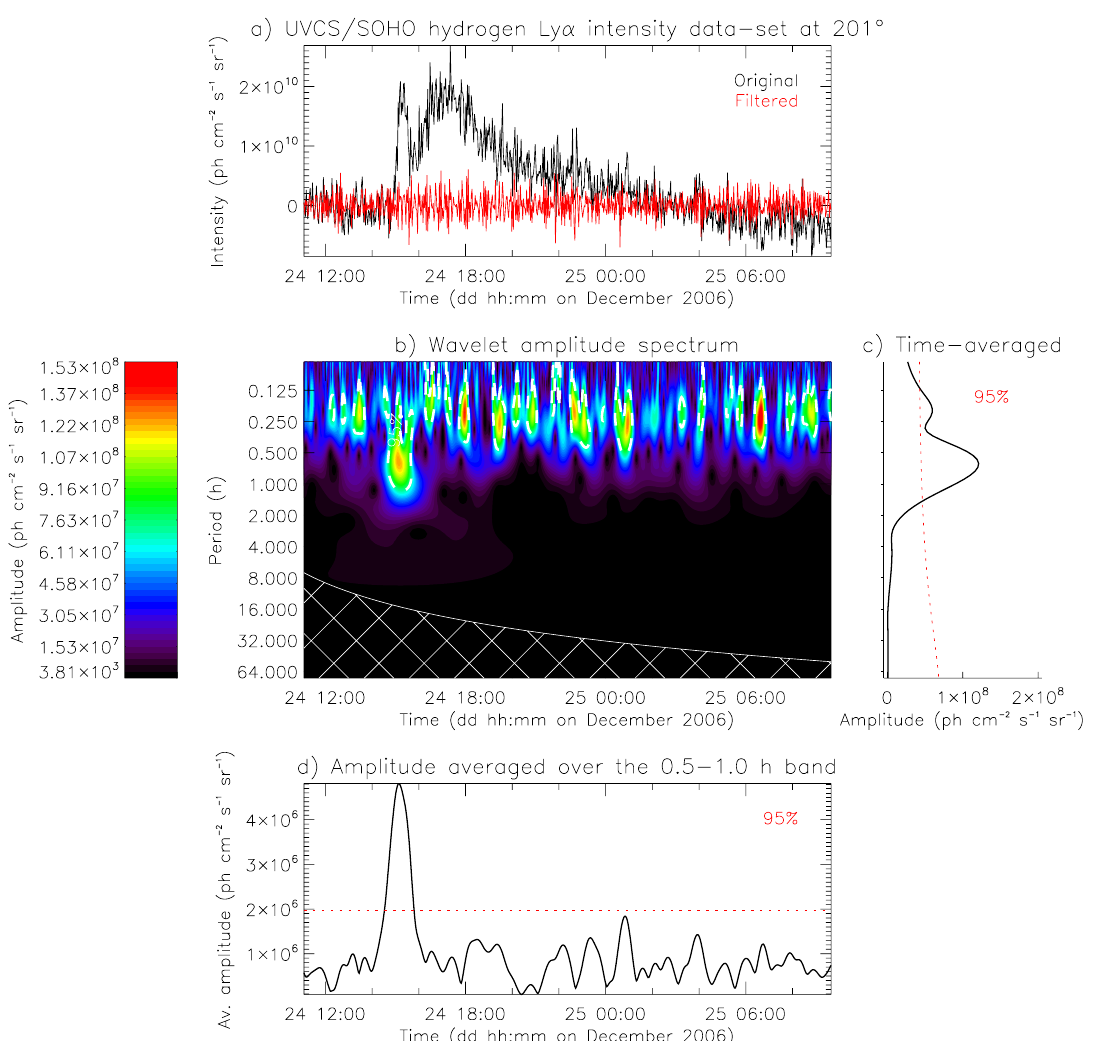
Figure 3. ( a ) H I Ly α intensity detected in pixel 34 of the UVCS slit, i.e., at 201 ◦ counterclockwise from the North pole, I Ly α ( φ 34 = 201 ◦ , t ) (black curve); the time series used for the wavelet analysis, = 201 ◦ , t ) (red curve), has been obtained by filtering out any trend of the CME signal due ˜ I Ly α ( φ 34 to the CME transit, from I Ly α ( φ 34 = 201 ◦ , t ) . ( b ) Wavelet amplitude spectrum of the filtered time series ˜ I Ly α ( φ 34 = 201 ◦ , t ) ( a ), using the Paul wavelet function; the left axis is the Fourier period (h); the bottom axis is time; the cross-hatched area marks the Cone Of Influence (COI) where edge effects become important; the thick dashed contours surround areas of statistical confidence larger than 95%. ( c ) Wavelet amplitude spectrum ( b ) averaged over the time interval from t 1 = 14:42 UT to t 2 = 15:30 UT, | W ( φ 34 = 201 ◦ , s )| ; the dotted red line is the 95% statistical confidence for a white-noise process. ( d ) Average of the wavelet amplitude ( b ) over the 0.5–1 h periodicity band, | W ( φ 34 = 201 ◦ , t )| ; the dotted red line is the 95% confidence